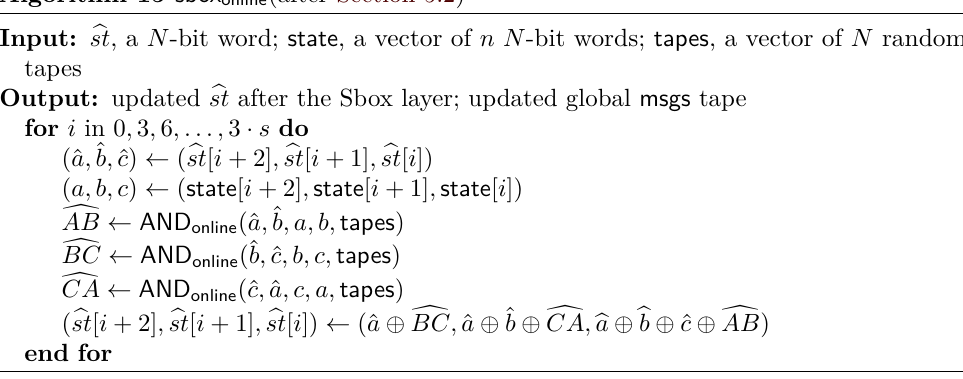
Algorithm 15 sbox online (after Section 5.2)